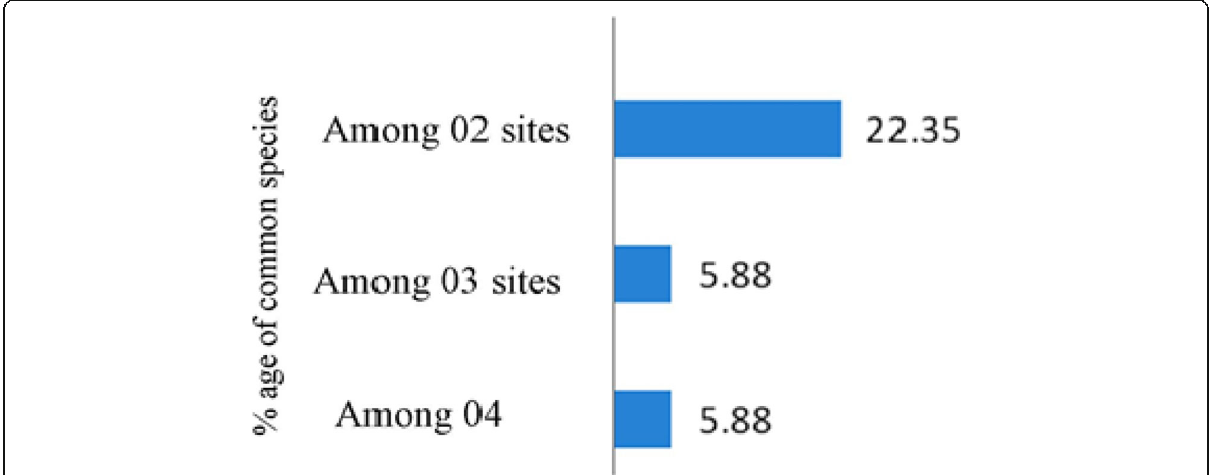
Fig. 3 Percentage of commonality among the species of the studied sites. This figure indicated the percentage of variations among the studied sites